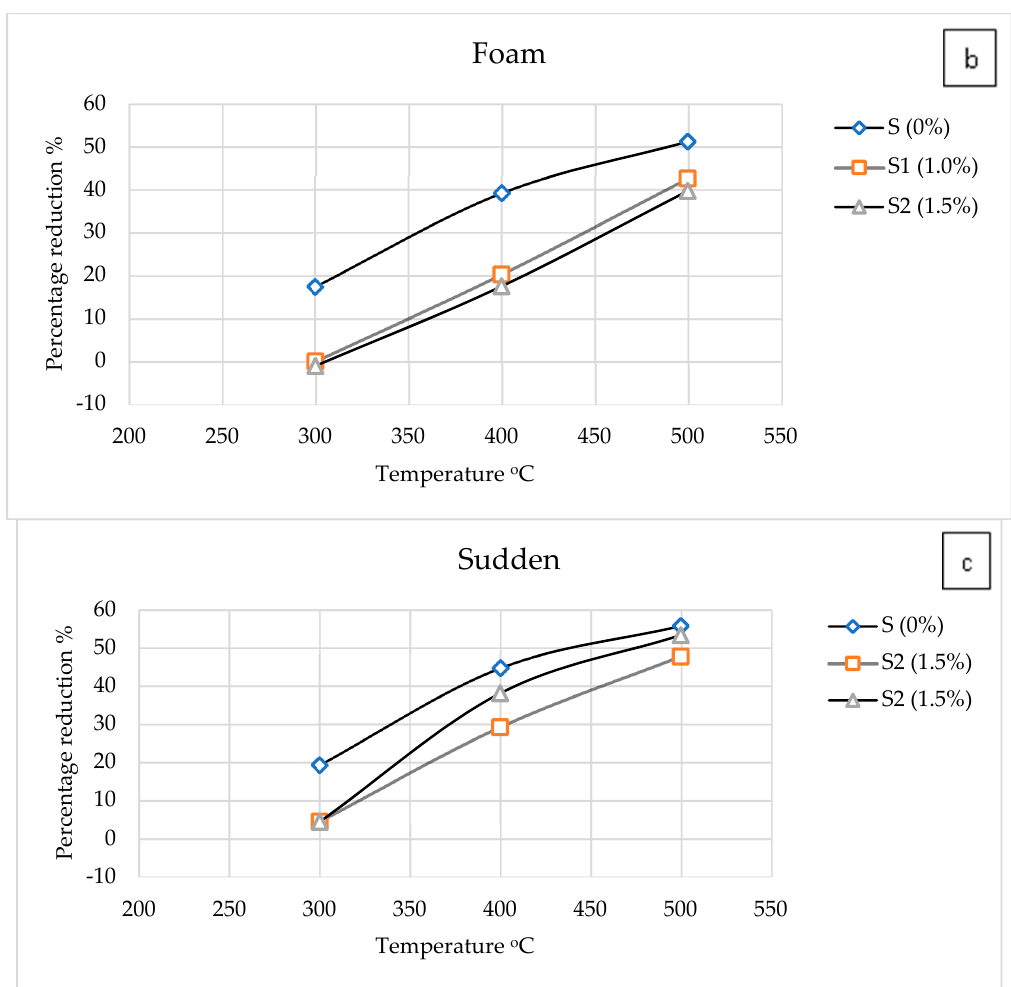
Figure 10. Percentage reduction in splitting tensile strength concerning all burning temperature and various (RPC) specimens: ( a ) Gradual cooling; ( b ) Foam cooling; and ( c ) Sudden cooling.